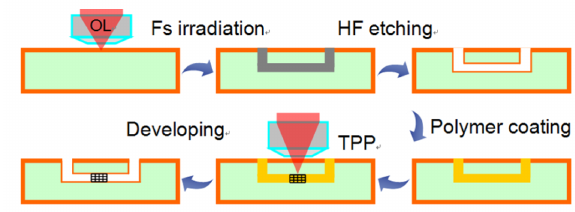
Figure 15: Schematic illustration of the procedure for fabrication of ship-in-a-bottle biochips by the hybrid technique, which mainly in- volves FLAE of photosensitive glass (femtosecond laser direct writ- ing followed by annealing, HF etching, a second anneal to smooth the inner surfaces), and TPP inside the microfluidic structures formed by FLAE (polymer filling, femtosecond laser direct writing and development)